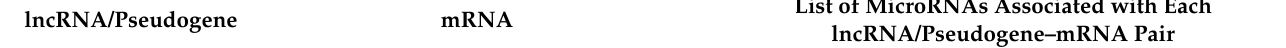
List of MicroRNAs Associated with Each lncRNA/Pseudogene–mRNA